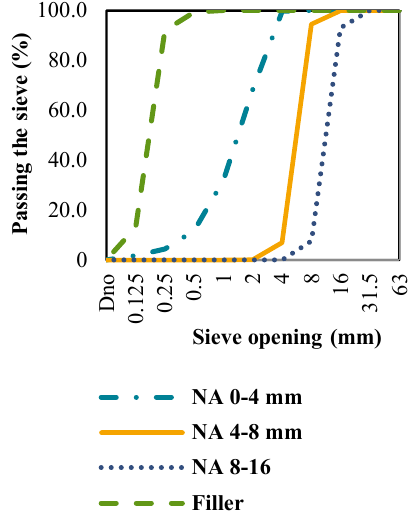
Figure 1. Grading curves for dolomite.